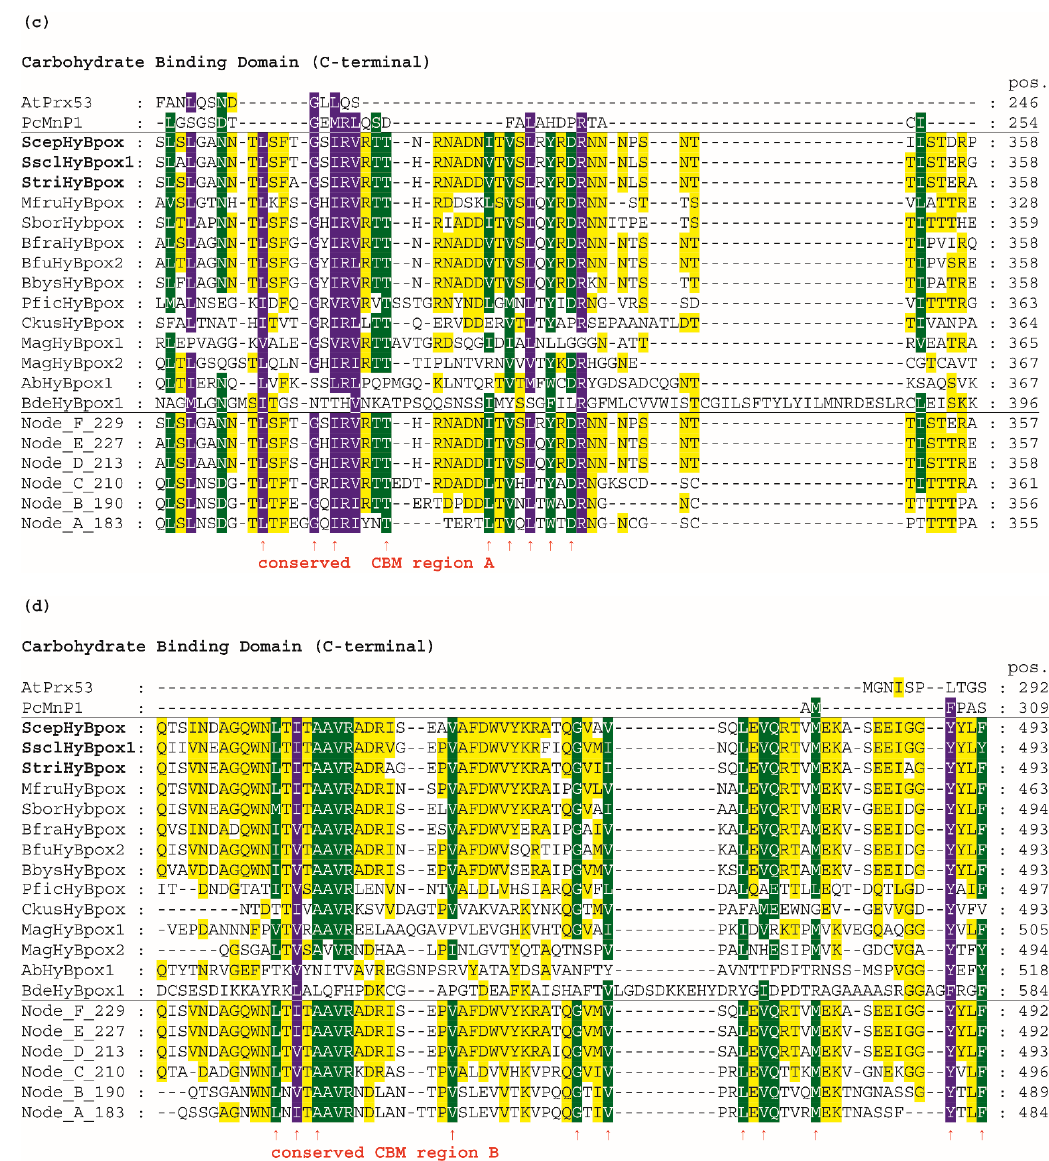
Figure 4. Multiple sequence alignment of 14 selected Hybrid B heme peroxidases with one typical plant-secretory and one typical fungal manganese peroxidase. Reconstructed protein sequences in 6 ancestral HyBpox nodes (labelled as in Figure 3) are given below. Only highly conserved regions are shown here. Complete sequence alignment is displayed in Figure S3. Conserved regions shown: ( a ) Distal side of prosthetic heme group; ( b ) Proximal side of prosthetic heme group; ( c ) Region A in carbohydrate-binding domain; ( d ) Region B in carbohydrate-binding domain. Secondary structure elements are from the 3D structure of PcMnp1. Abbreviations of sequence names are explained in Table S2, with corresponding accession numbers. Colour scheme: blue >90%, green >75%, and yellow >50% conservation.